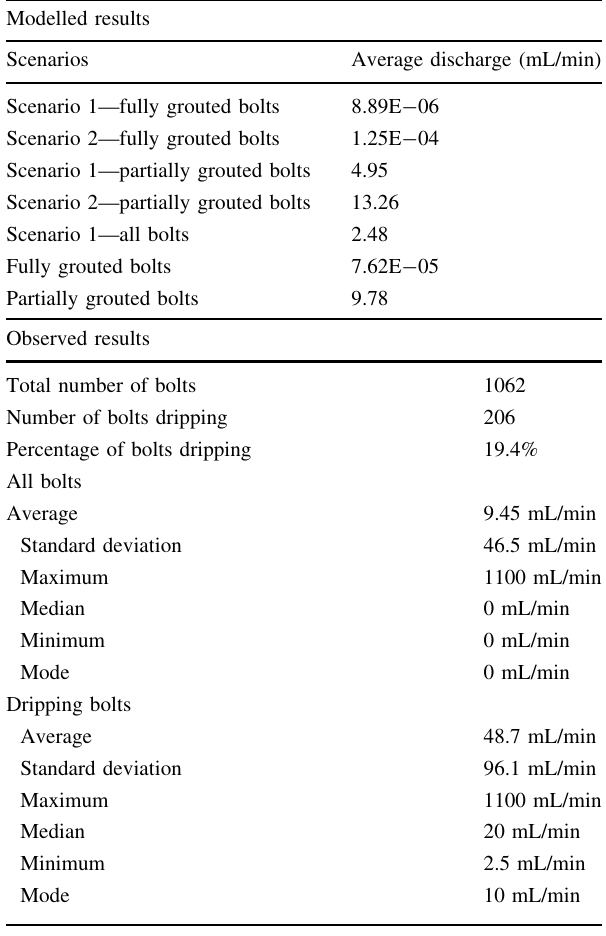
Table 3 Statistics of observed groundwater discharge flow rates after Craig et al. (2016) and modelled